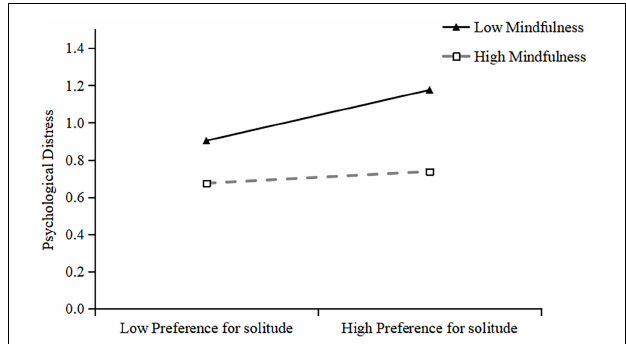
FIGURE 3 | Mindfulness moderated the relationship between preference for solitude and psychological distress.